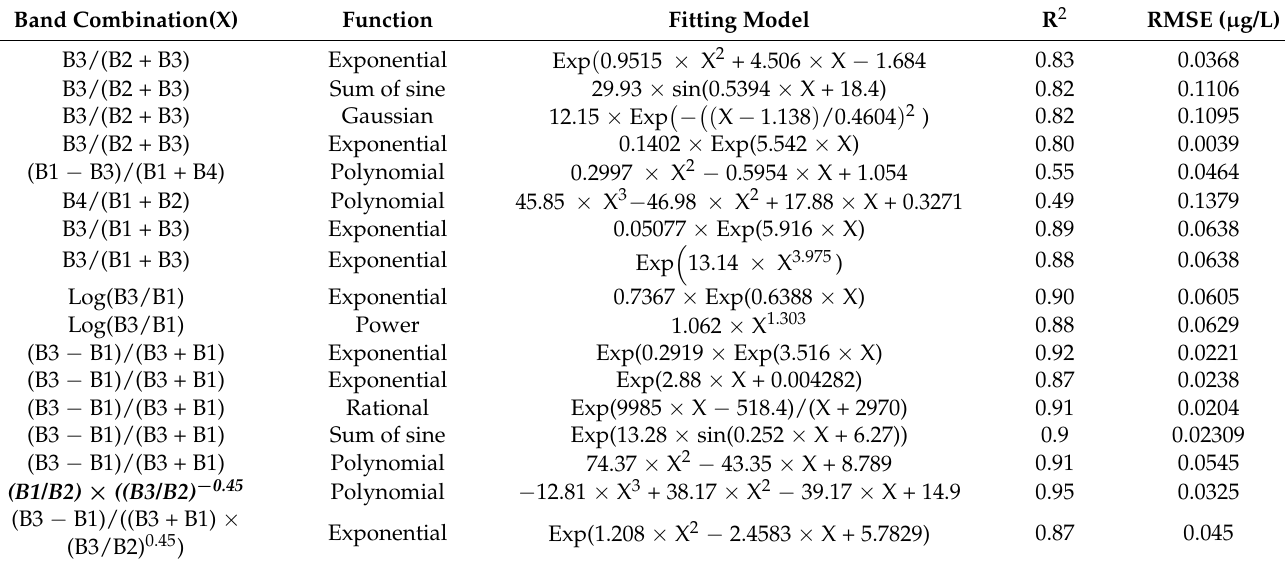
Table 3. Models of band combinations and the corresponding correlation coefficients (R 2 ) and RMSE.